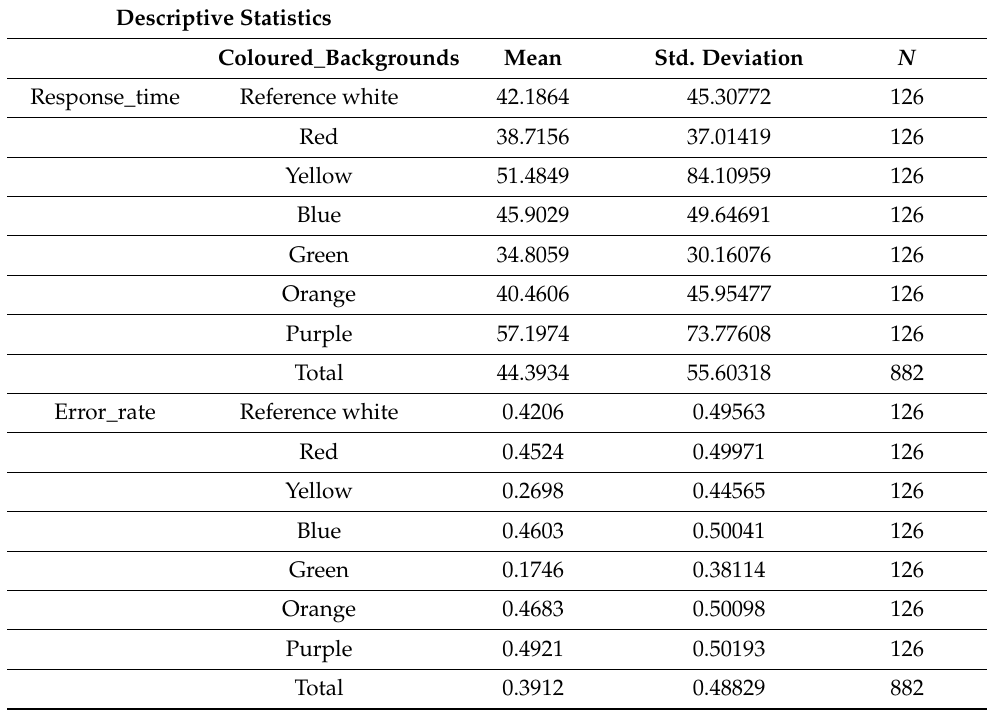
Table A3. MANOVO Analysis of People’s Responses to Colours—General